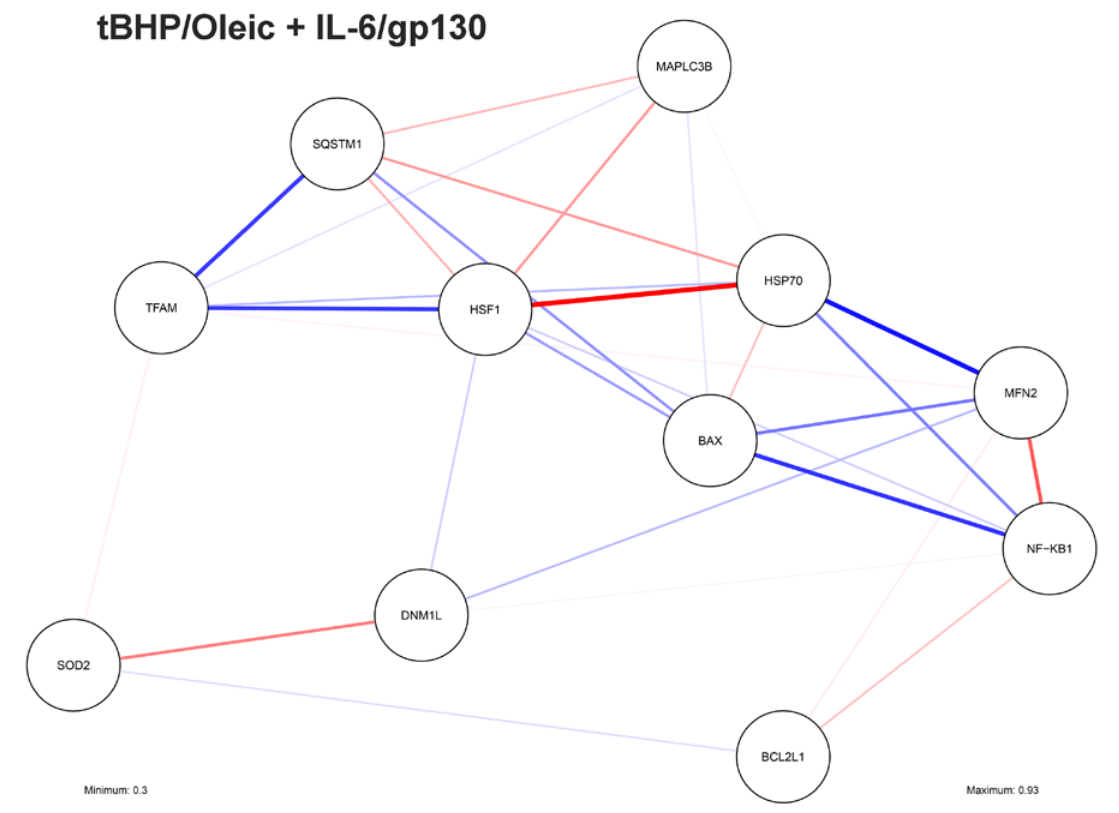
Figure 8. Correlations between gene expression in HepG2 with tBHP/Oleic. Blue lines are negative correlations, red lines are positive correlations. The line thickness indicates the strength of the correlation between the parameters.